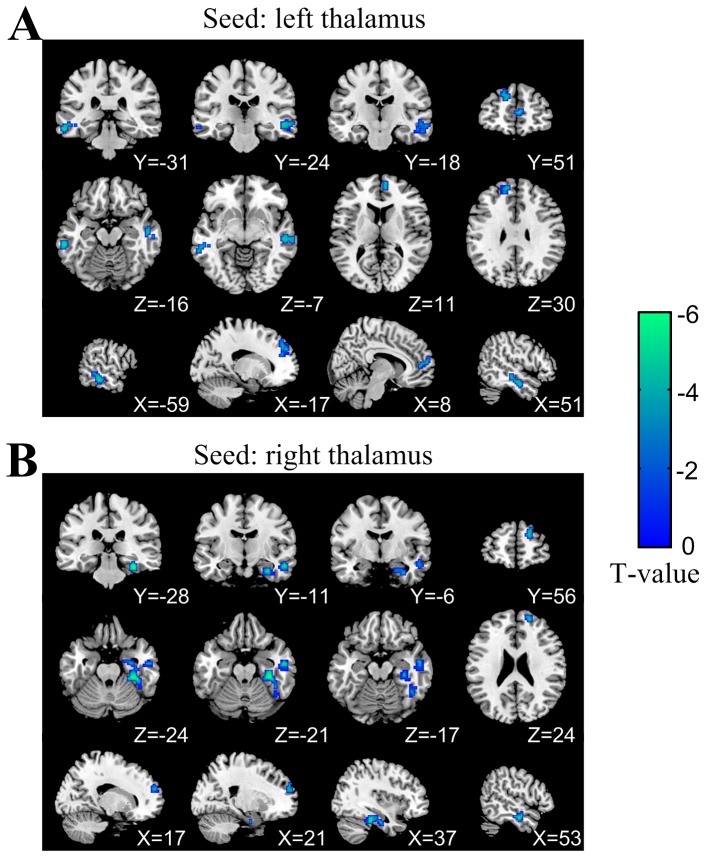
Brain areas that exhibited decreased functional connectivity with (A) the left thalamus and (B) right thalamus after 36 h TSD.In the transverse and coronal views, the left side of the images represents the left hemisphere of the brain.